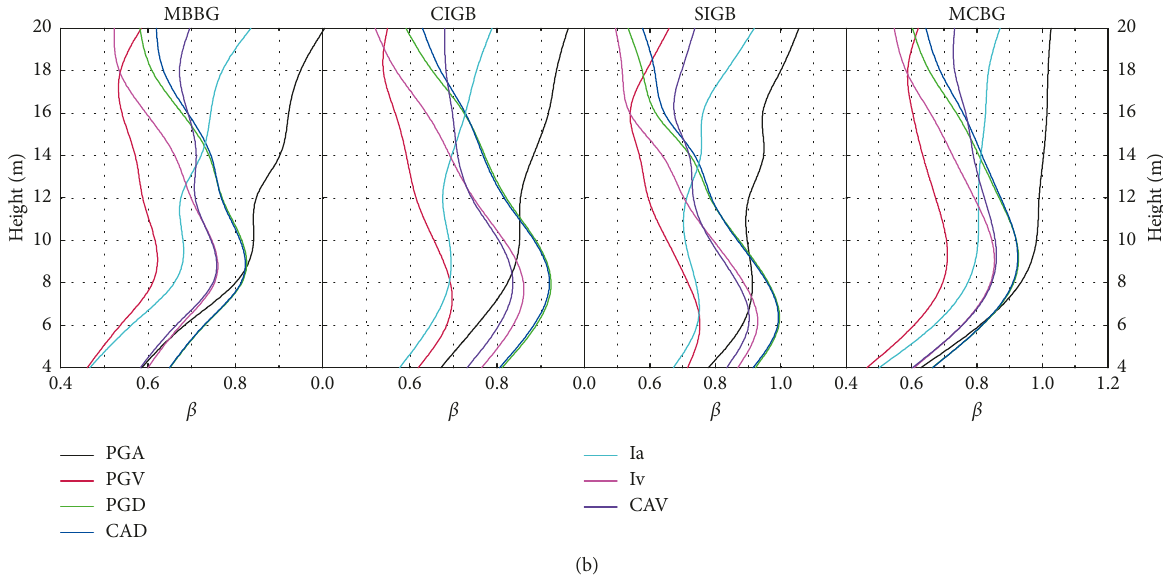
Figure 11: IMs efficiency comparison for (a) the pier curvature ductility along the longitudinal direction and (b) the pier curvature ductility along the transverse